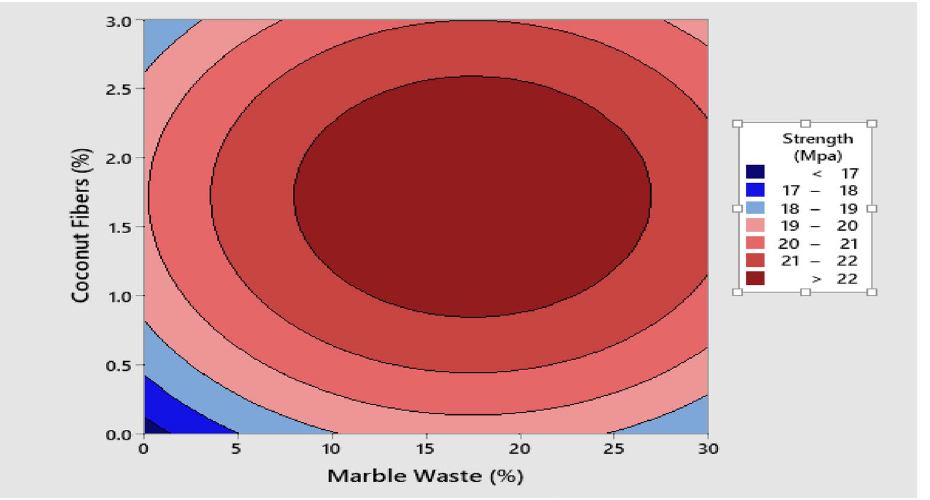
Figure 11. Contour plot for compressive